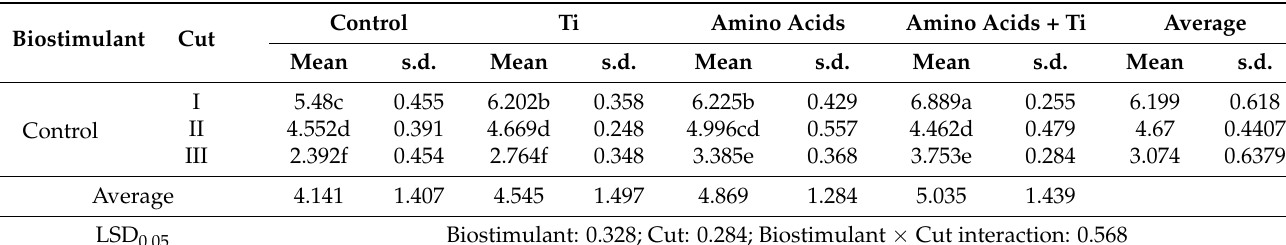
Table 2. Mean values, standard deviations (s.d.), Fisher’s least significant differences (LSD) and homogeneous groups of the dry matter yield (t · ha − 1 ) of Poa pratensis